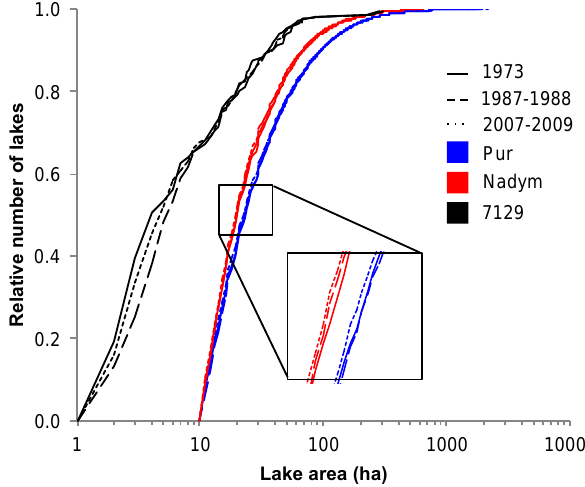
Figure 2. Relative number of lakes with different lake areas (ha) for the Nadym and